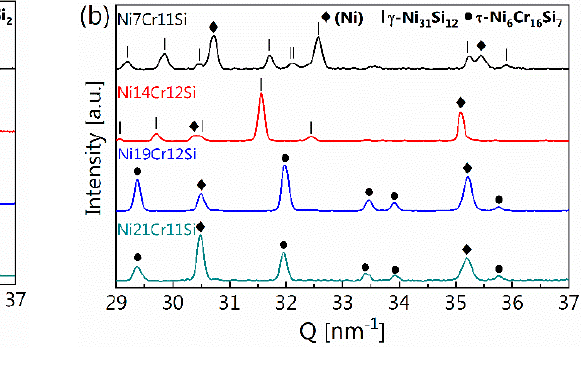
Figure 3. Synchrotron diffraction patterns were collected throughout the melting and the solidification cycle for three of the investigated alloys: Ni7Cr11Si, Ni14Cr12Si and Ni21Cr11Si. ( a ): 1D profile of diffraction pattern of Ni21Cr11Si melt; ( b ): Map of diffraction patterns; ( c , d ): Maps of diffraction patterns at the early stages of cooling; ( e ) diffraction pattern of liquid and solid Ni14Cr12Si.